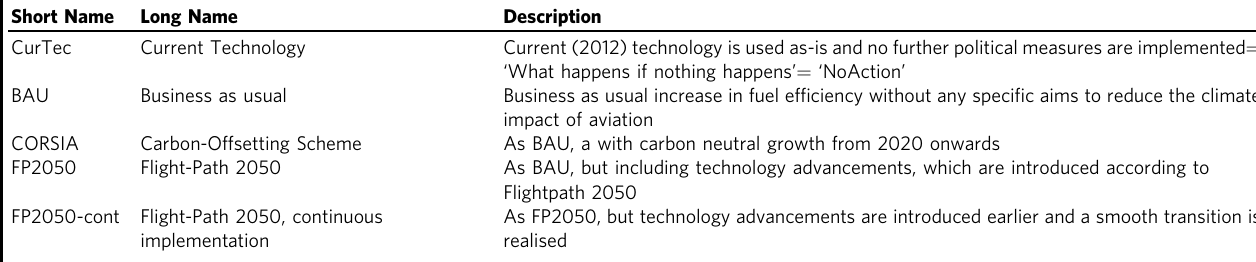
Table 1 Summary of the scenarios used in the analysis.